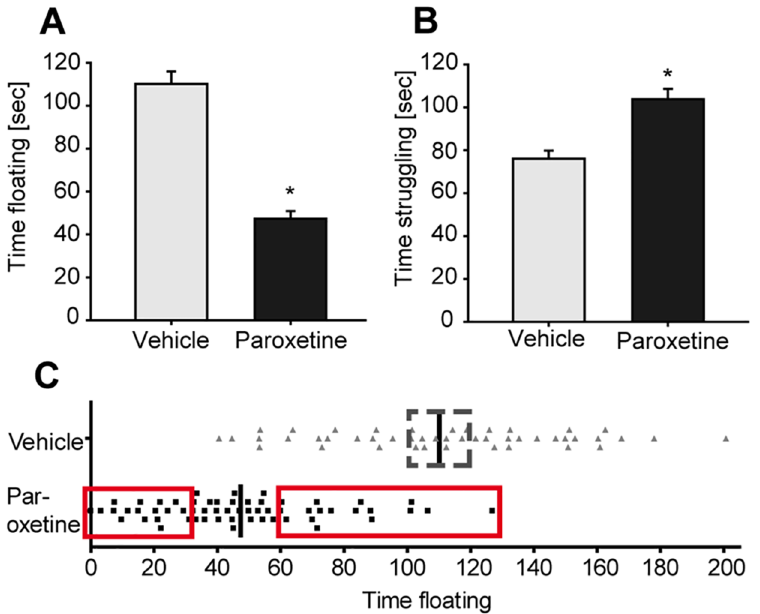
Fig 3. A 14-day paroxetine treatment significantly reduces depression-like behavior in the FST. (A) Paroxetine-treatedanimalsshoweda reductionin time floating comparedto vehicle-treated animals. (B) Paroxetine significantly increasedactive copingstrategies, i.e., time struggling,comparedto vehicle-treated animals. (C) Identification of different respondergroups accordingto their performance in the FST. Animals indicatedin the red squares are referred as goodand poor treatment responders. Animalsthat showeda very high time floating represent the poor treatment responder, whereasanimalsthat showeda very low time floatingrepresent the good treatment responder. Animalsindicatedin the dotted-linesquare represent internalcontrol groups. Animalswithin the vehicle-treatedgroup served as a vehicle-treated control group. * indicatessignificantdifference betweenthe vehicle-treated control group and the paroxetine-treatedgroup, p < 0.000. All raw data for Fig 3 are availablein S2 Data. FST, forced swim